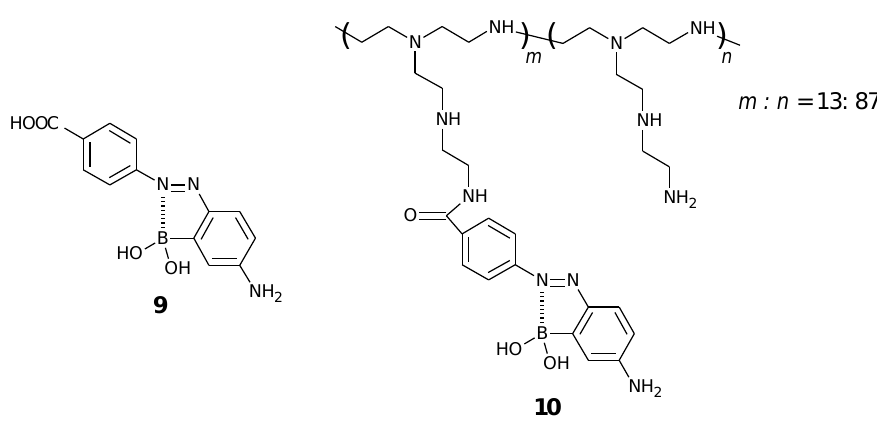
Figure 11. Chemical structures of dye 9 and 10 .